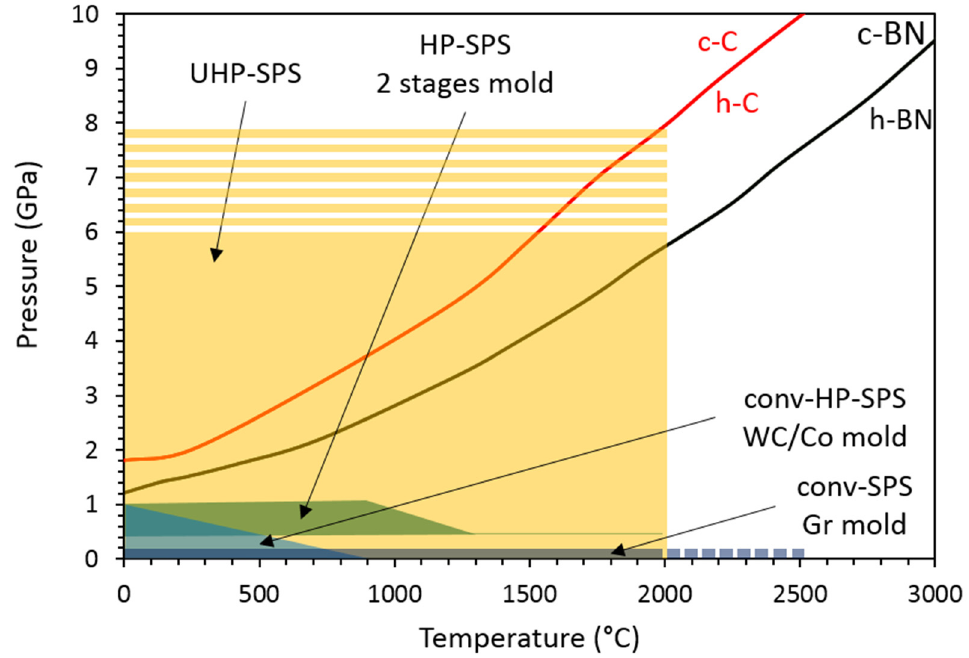
Figure 3. Pressure–temperature diagram showing filed of applications of the different SPS setups. Conv-SPS and HP-SPS are both used in conventional equipment and never exceed 1 GPa . Maximum temperature depends a lot on materials constituting the mold, i.e., graphite, WC/Co, WC or SiC. In UHP-SPS equipment, a wide range of pressure–temperature conditions are covered offering the possibility to study sintering behavior of high-pressure phases such as c-C (red-curve) and c-BN (black curve) without any additions of binder.